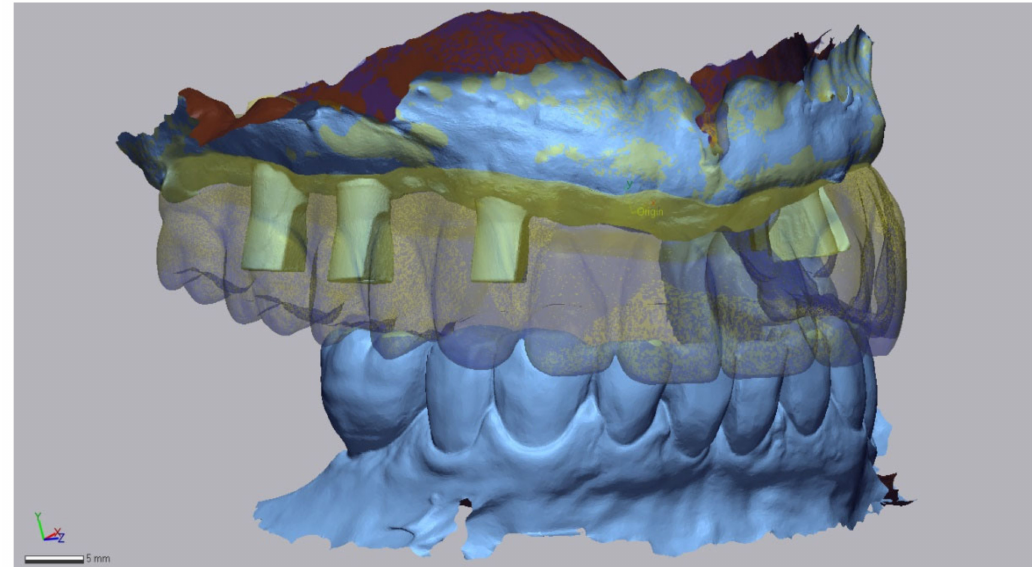
Figure 10. STL-set T1: Scan data of the analog bite registration. A digital impression of the maxillary arch with the established full-arch fixed implant prosthesis after 4 months in situ (transparently yellow) combined with a digital impression of the maxillary dual-function scan bodies, a digital mandibular antagonist impression and two buccal bite-scans (Geomagic Control X, 3D Systems Inc., Rock Hill, SC, USA).